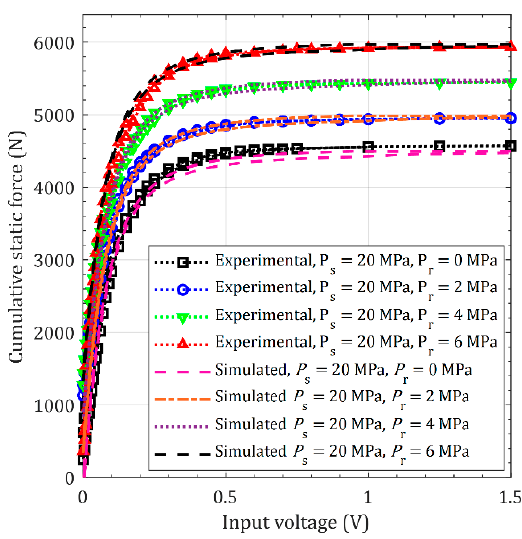
Figure 16. Experimental and simulated cumulative static force response operating with servo valve in conjunction with rear pressure.